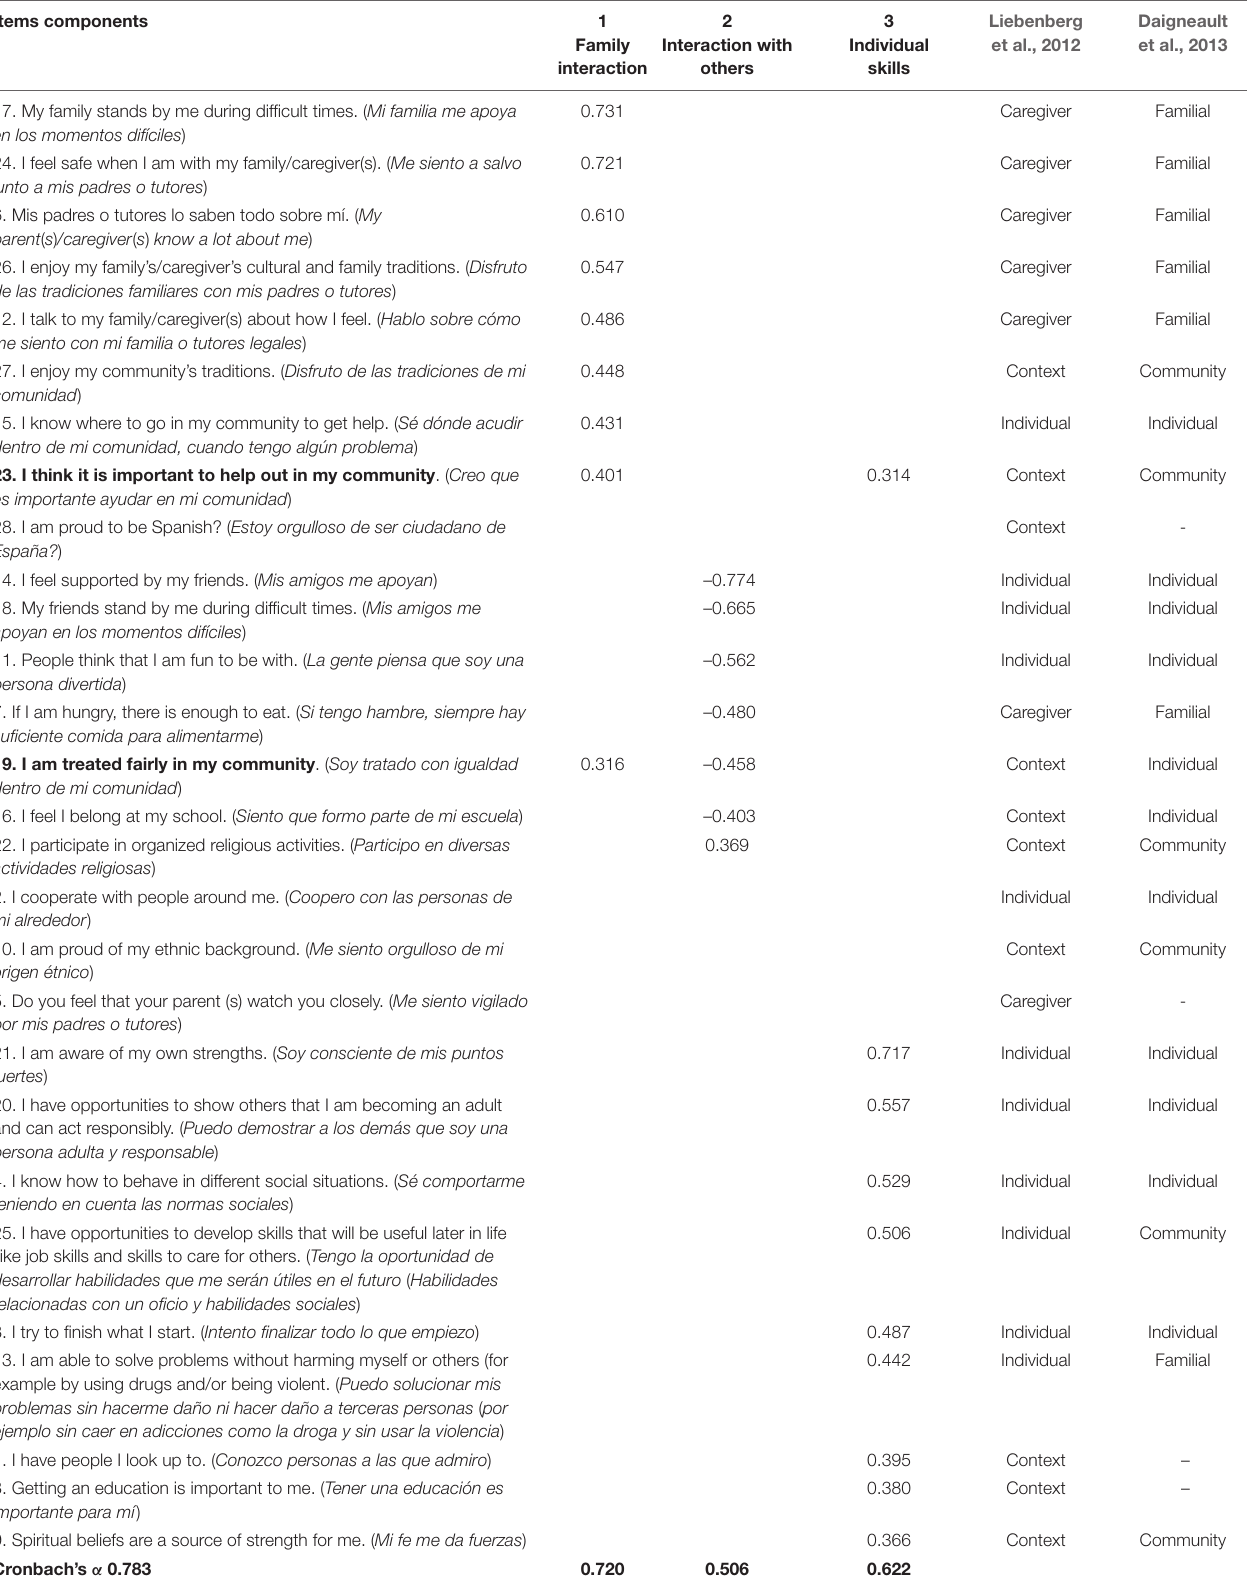
TABLE 1 | Summary of factor loadings for principal component analysis for Oblimin three factor solution of the CYRM-28 (Spanish version). Items